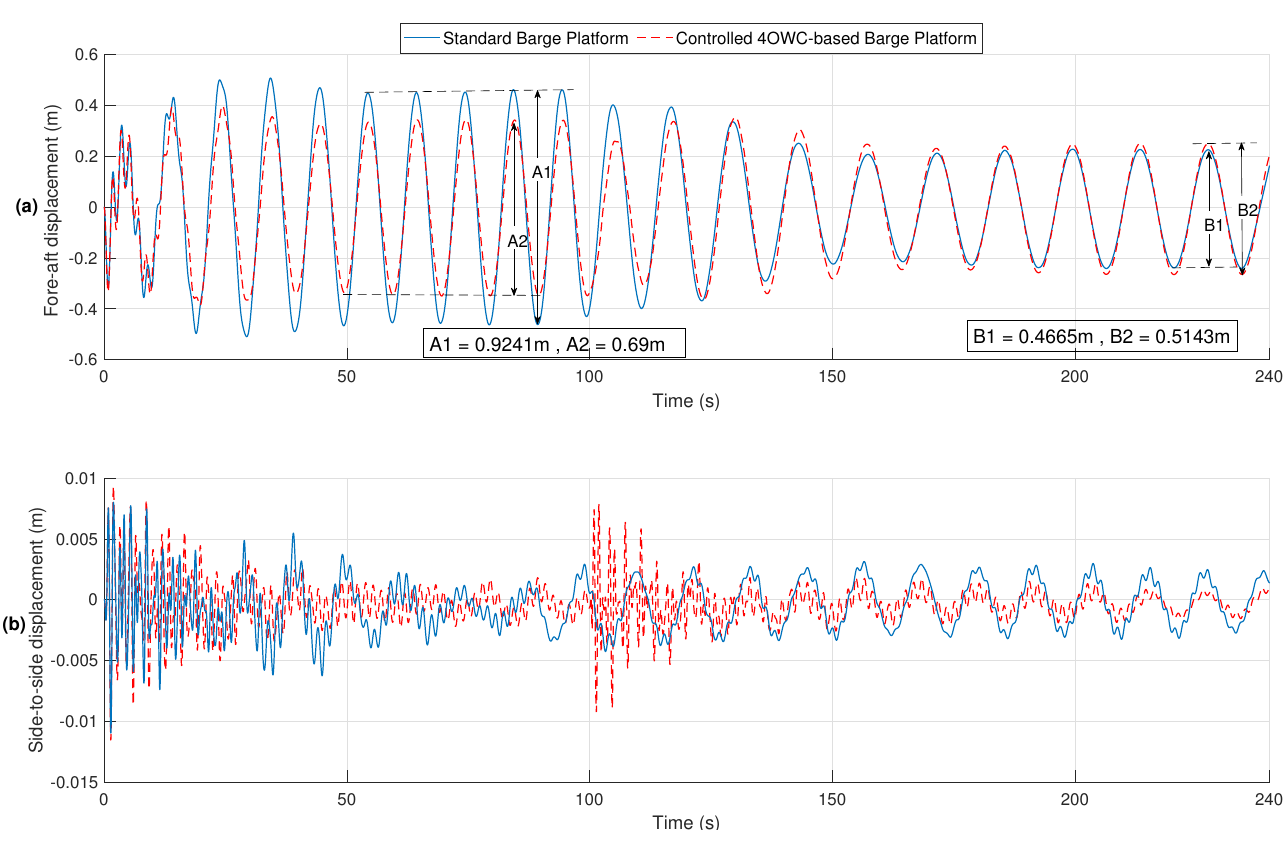
Figure 10. Top tower displacements. ( a ) Fore-aft. ( b ) Side-to-side. For the period of 10 s, the FRAOs in Figures 4h and 5b for the open-OWCs-based barge platform is less than that of for standard barge platform. It means that it is expected to see less oscillations in fore-aft for the open-OWCs-based barge platform, compared to standard barge platform. In Figure 10a starting from 0 s to 100 s with the wave period 10 s, the controller opens all the valves so that the platform acts like the open-OWCs-based barge platform. As a result as shown in the figure, the for-aft oscillations decreased by 25% from 0.9241 m for the standard barge platform to 0.69 m for the controlled 4OWC-based barge platform. However, as it is expected from the FRAOs in Figures 4f and 5a for